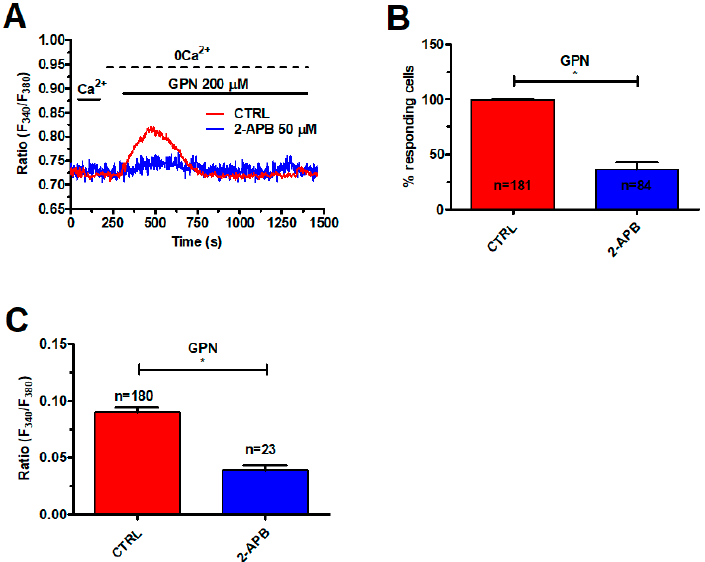
Figure 3. InsP 3 Rs support the Ca 2 + response to GPN. ( A ) 2-Aminoethoxydiphenyl borate (2-APB) (50 µ M, 30 min), a selective InsP 3 R blocker under 0Ca 2 + conditions, impaired the Ca 2 + response to GPN (200 µ M) in mCRC cells. ( B ) mean ± SE of the percentage of mCRC cells responding to GPN in the absence and in the presence of 2-APB. The asterisk indicates p < 0.05. ( C ) mean ± SE of the amplitude of the Ca 2 + response to GPN in the absence and in the presence of 2-APB. The asterisk indicates p < 0.05.